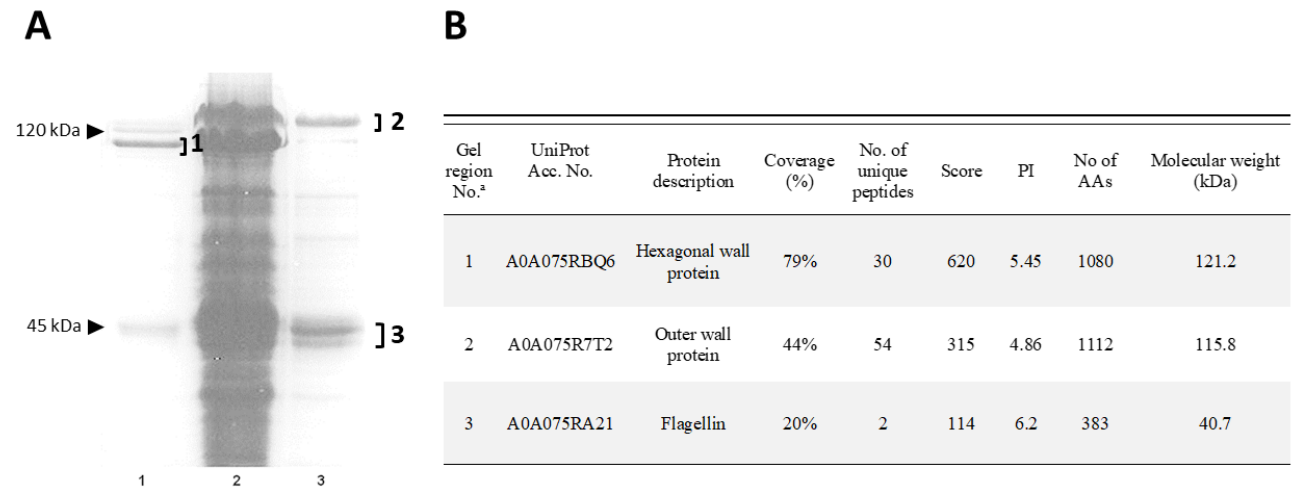
Figure 2. Brevibacillus laterosporus vegetative cell major proteins. ( A ) Protein pattern of whole vegetative cells (Lane 2) and surface-layer proteins extracted with guanidine hydrochloride (Lane 1) and EDTA (Lane 3) methods. ( B ) Major protein band identification by mass spectrometry. “a” indicate gel regions excised from 1-DE gel for Mass Spectrometry analyses numbers; “1, 2, and 3” indicate the specific gel region excised from the gel.